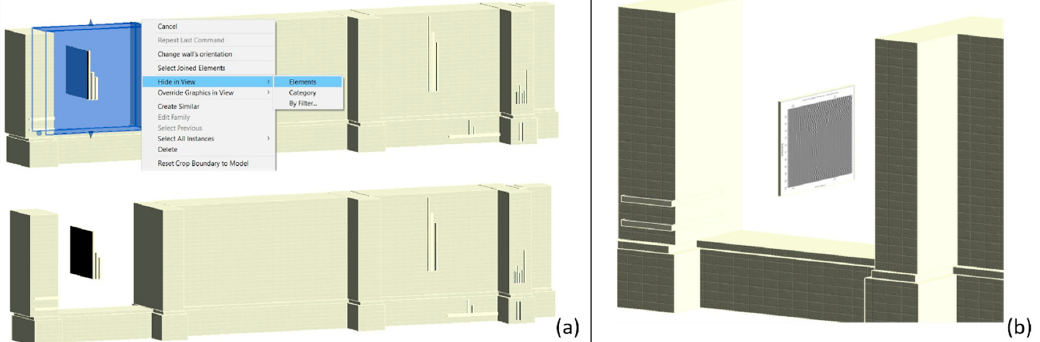
Figure 16. Revit model showing an existing panel of the façade of the Founder’s Chapel containing a fictitious wall object cladded with a radargram: ( a ) visual disclosure of the radargram by hiding the wall using the Revit command “Hide in view”, and ( b ) visualization of the radargram (cladded to a fictitious object).